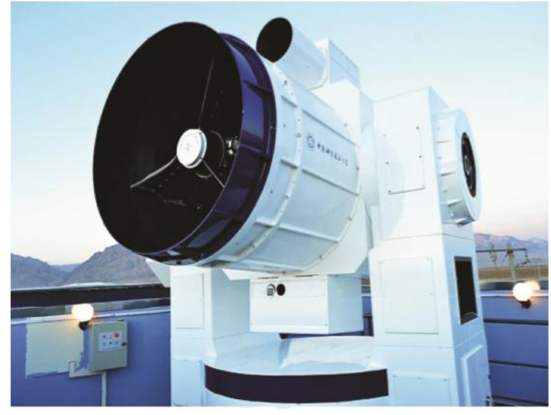
Figure 2. The alt-az telescope.